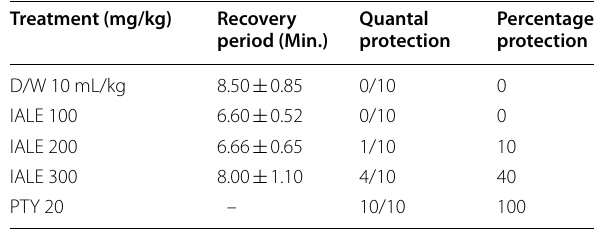
Table 2 Quantitative phytochemical constituents of Ipomoea asarifolia ethanolic leaf extract